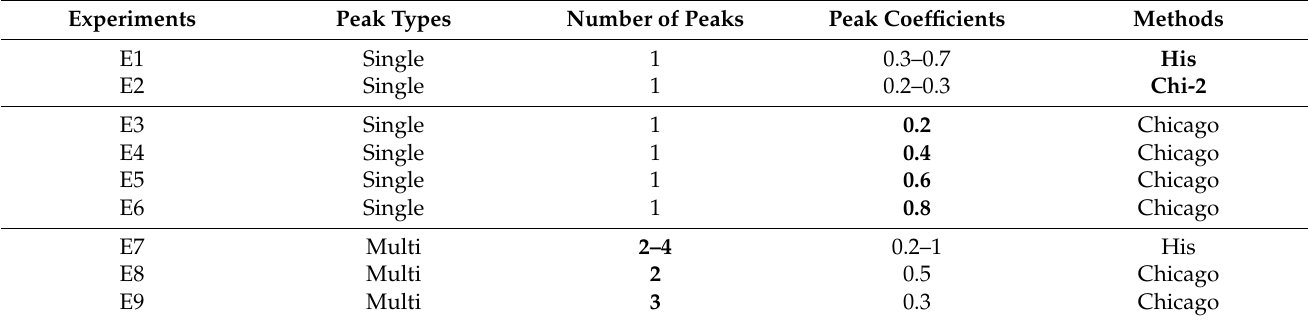
Table 4. Experimental